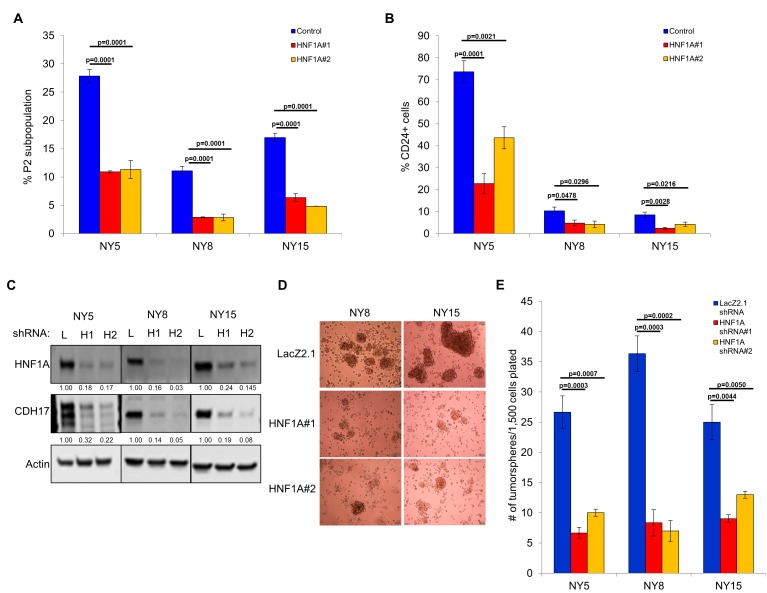
Knockdown of HNF1A depletes CSC numbers.(A) Multiple PDA cells were transfected with HNF1A-targeting siRNA or non-targeting control siRNA for 6 days. Surface expression of CD44 and EPCAM was measured by flow cytometry, and the percentage of CD44High/EPCAMHigh (P2) cells are represented (mean ± SEM, n = 3). Statistical difference was determined by one-way ANOVA with Dunnett’s multiple comparisons test. (B) Quantitation of CD24 +cells in multiple primary PDA cells following HNF1A knockdown for 6 days, n = 4. Statistical difference was determined by one-way ANOVA with Dunnett’s multiple comparisons test. (C) NY5, NY8, and NY15 cells expressing LacZ2.1 (L) or two distinct HNF1A-targeting shRNAs (H1 and H2) were lysed and western blotted for HNF1A, CDH17, and Actin, showing effective knockdown of HNF1A and downstream signaling (CDH17). Quantitation of proteins is indicated below the respective blots. (D, E) NY5, NY8, and NY15 cells expressing LacZ2.1 or HNF1A-targeting shRNAs were grown in tumorsphere media on non-adherent plates (1500 cells/well). The number of tumorspheres formed after 6 days were counted (n = 3). Representative images of spheres (100X magnification) are shown in (F) and in Figure 3—figure supplement 1, with quantitation in (E). Statistical difference was determined by one-way ANOVA with Dunnett’s multiple comparisons test. Related data can be found in Figure 3—figure supplement 1.10.7554/eLife.33947.014Figure 3—source data 1.Quantitation of the P2 subpopulation, CD24 expression, and tumorsphere formation following HNF1A knockdown.